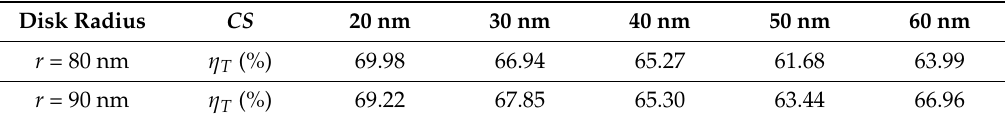
Table 2. Total efficiency η T at different split sizes.